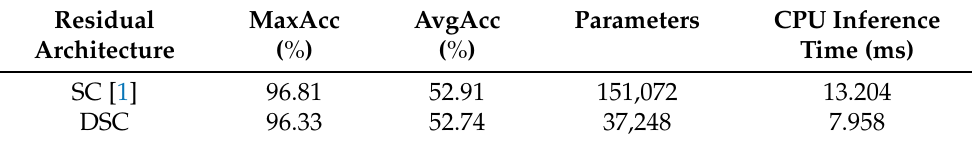
Table 5. Performance comparison between DSC and SC on RadioML2018.01A dataset.